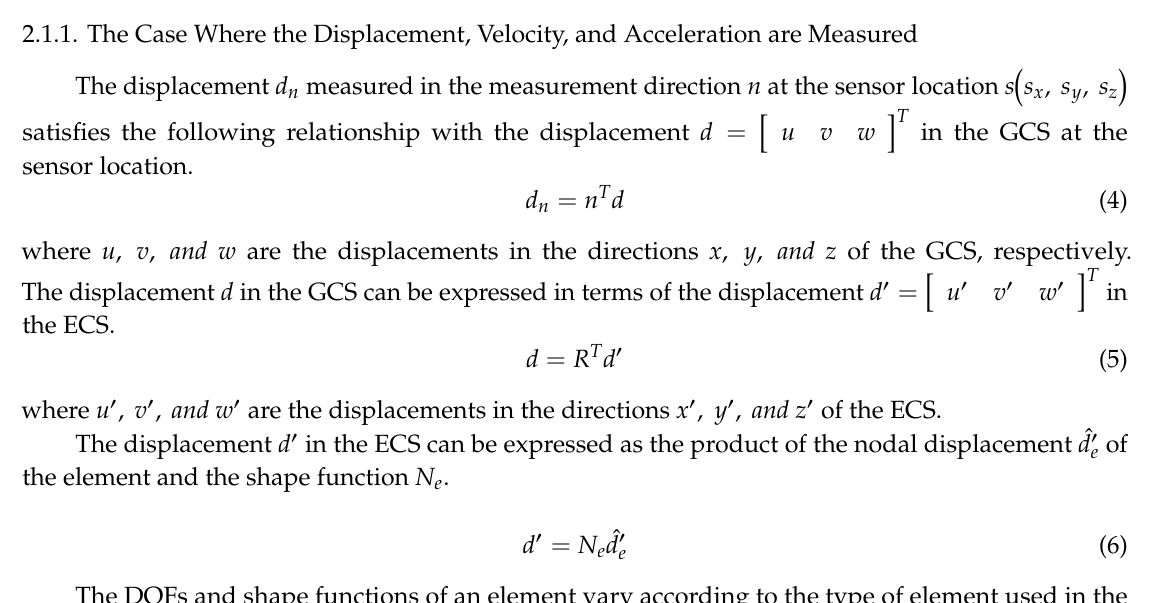
Figure 3. Structure shape and sensor layout of numerical example (unit: m).